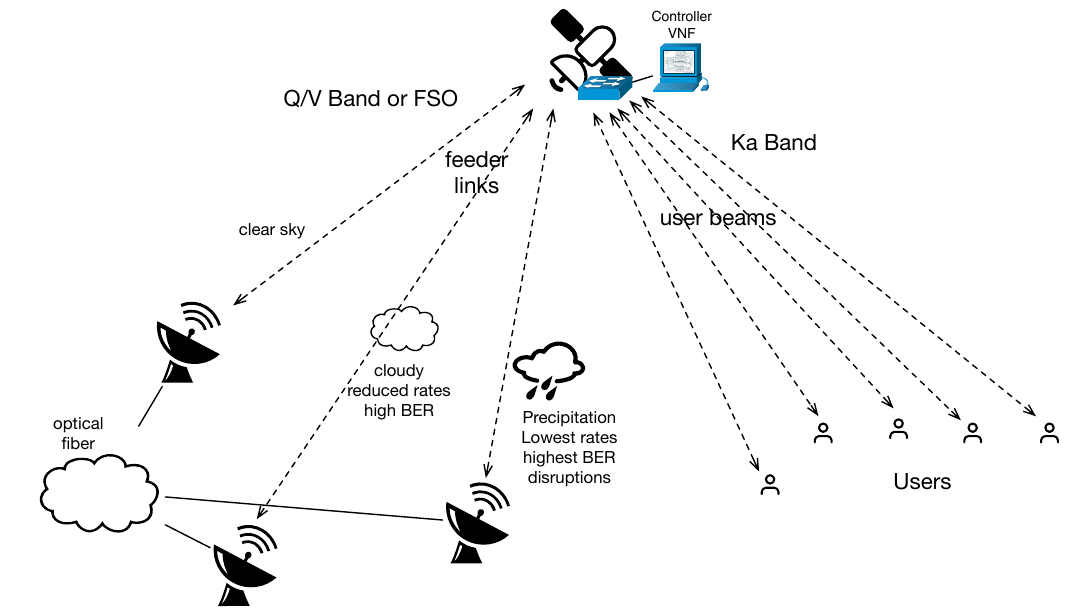
Figure 1. System architecture with a virtual network function (VNF) providing a routing function for a High Throughput Satellite (HTS)